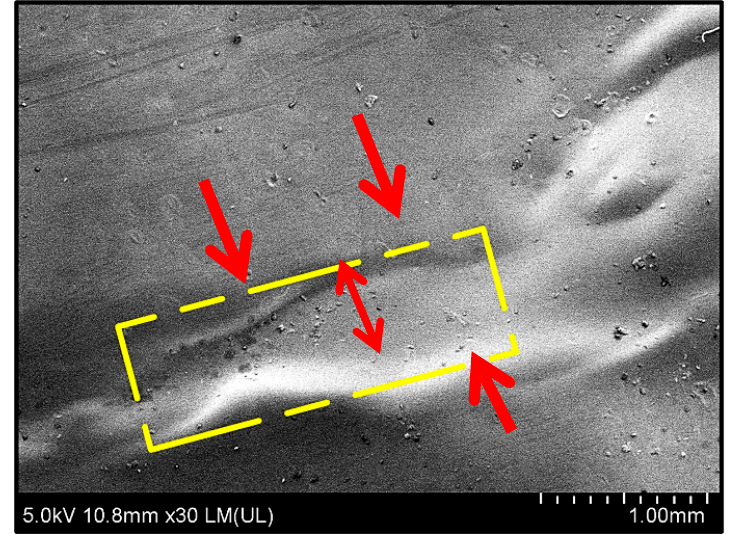
Figure 7. FE-SEM micrographs of healed Alg–Pec films. Arrows are pointing at healed regions and boundaries.